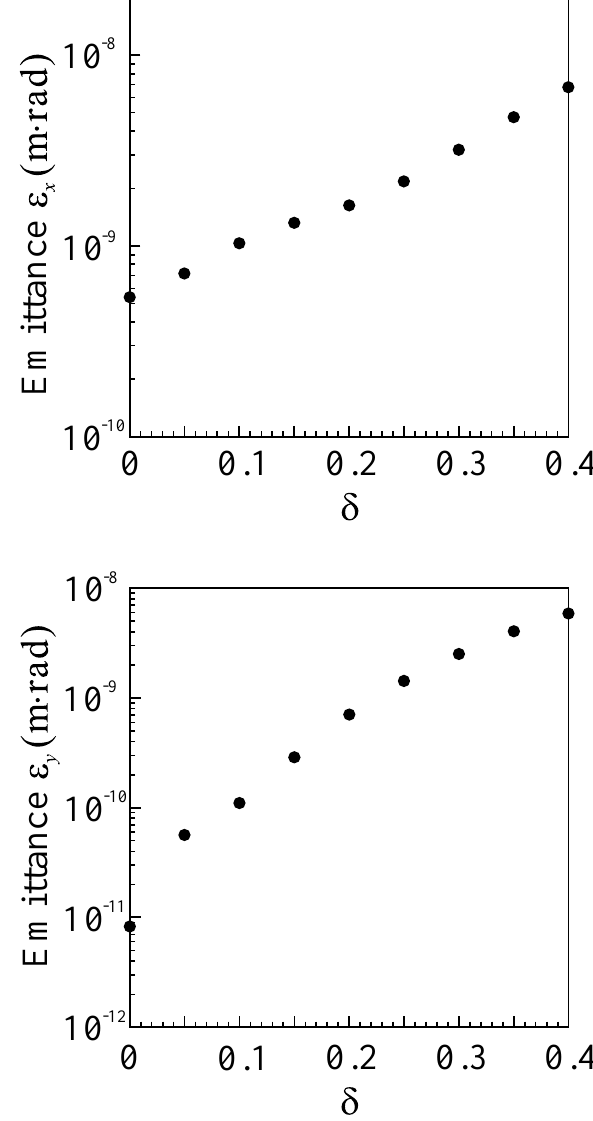
FIG. 10. Dependence of the emittances in the defocusing optics without chromaticity correction on the relative energy spread.